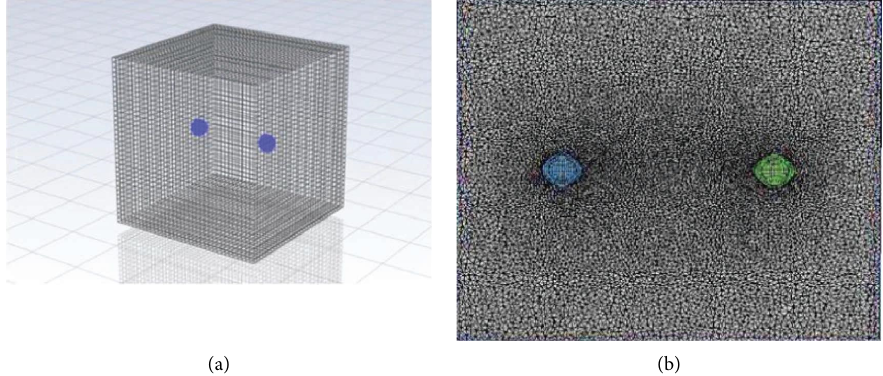
Figure 2: Geometric model and mesh generation of simulation